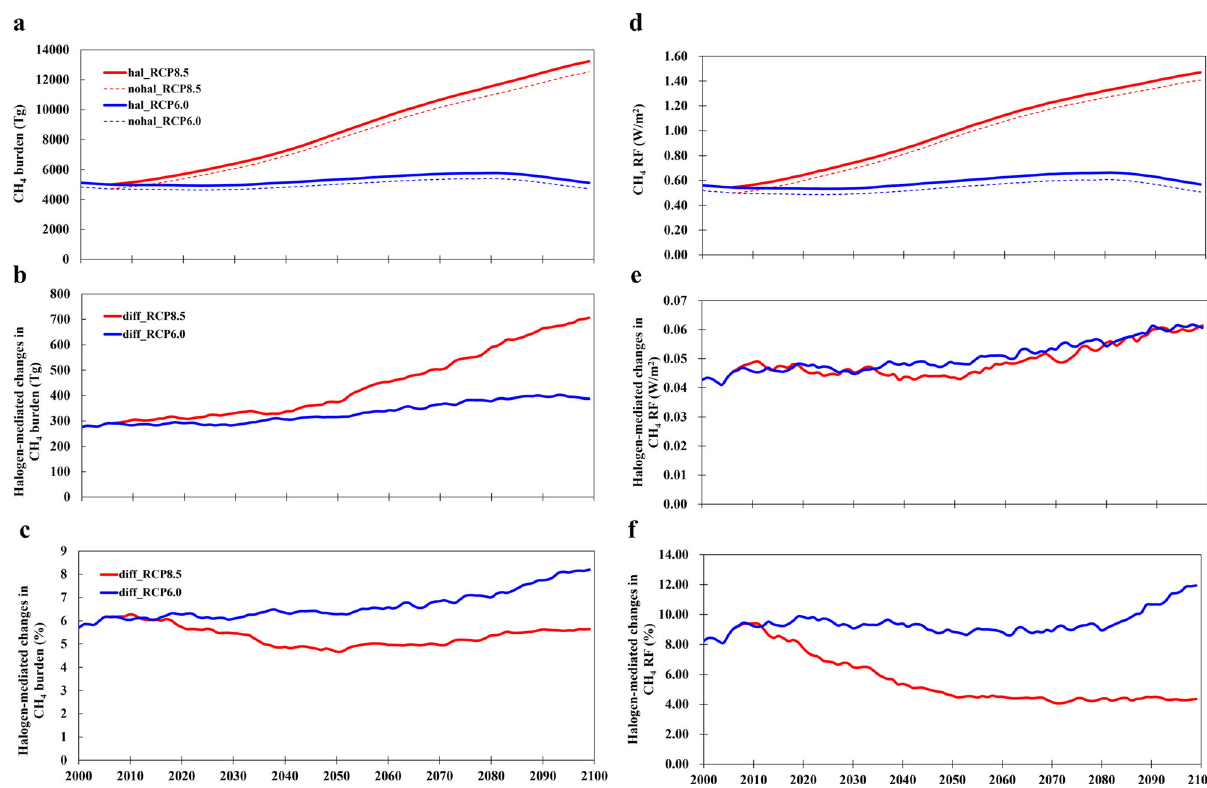
Fig. 5 Evolution of halogen-mediated change in CH 4 burden and radiative forcing in the 21st century for RCP6.0 (blue line) and RCP8.5 (red line) scenarios. a CH 4 burden (Tg) for simulations with (HAL, solid line) and without (noHAL, dashed line) halogens; b Halogen-mediated change in CH 4 burden in the unit of Tg; c The same as ( b ) but in percentage; d Radiative forcing (W/m 2 ) of CH 4 compared to pre-industrial level with (HAL, solid line) and without (noHAL, dashed line) halogens; e Halogen-mediated change in CH 4 radiative forcing in the unit of W/m 2 ; f The same as ( e ) but in percentage. Note that the results for RCP8.5 are only shown from 2006 to 2100 and the results before 2006 are identical to those in